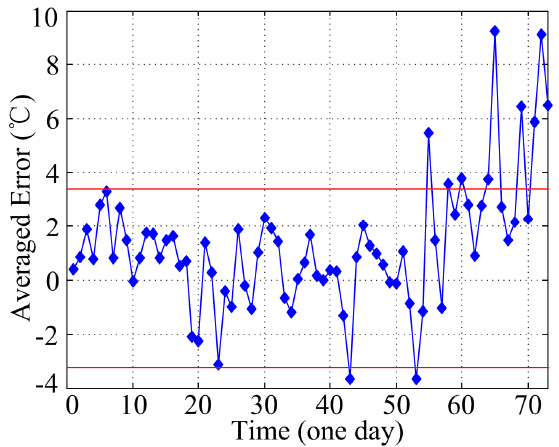
Figure 16. Averaged residual over one day of model for the temperature of generator bearing B.